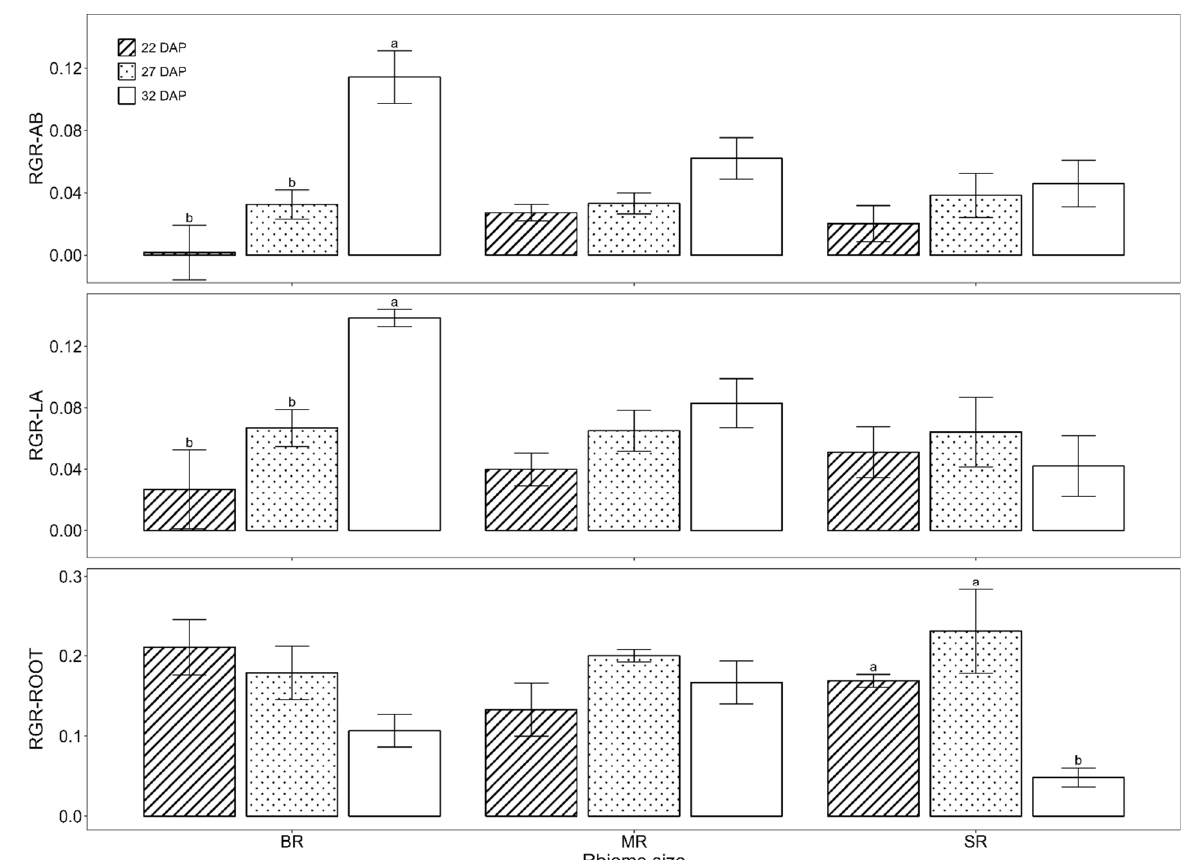
Figure 2. The relative growth rates of aboveground dry biomass, leaf area and total fibrous root length on 22, 27 and 32 DAP in EXP.1. Note: BR, MR and SR refer to the big, medium and small rhizome weight in EXP.1, respectively. The different lower-case letters indicate significant probability difference at p < 0.05 among sampling dates. The error bars represent standard errors ( n = 3). In EXP.2, aboveground dry biomass of seedlings was affected by Section number on three dates ( p < 0.05), not by Bud size. Aboveground dry biomass was always higher in S2 than in S3 and S4 across bud sizes. The aboveground dry biomass was lower in S3 treatment than in S2 treatment on 32 DAP and 46 DAP ( p < 0.05). Total fibrous root length of plantlets was influenced by both Section number and Bud size. The total fibrous root length was lowest in S4 treatment compared to in S2 and S3 treatments, on all three sam- pling dates ( p < 0.05). Meanwhile, plantlets had lower total fibrous root length in SB treat- ment than in LB treatment on all three dates (Table 3). Table 3. The aboveground dry biomass and fibrous root length on three dates in EXP.2. Data shown are Mean ± s.e. ( n = 3). DAP